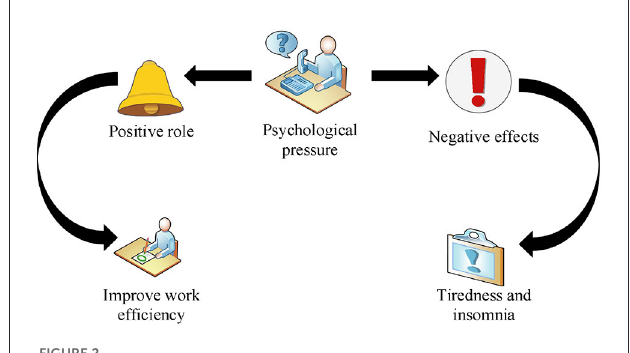
FIGURE2 The dual role of civil servants’ psychological